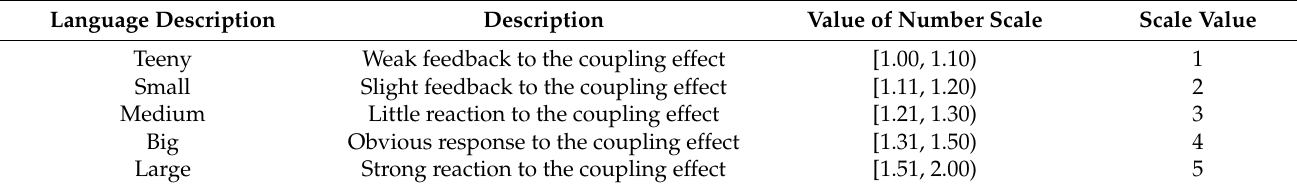
Table 5. Vulnerability level of the train operation department safety behavior risk.